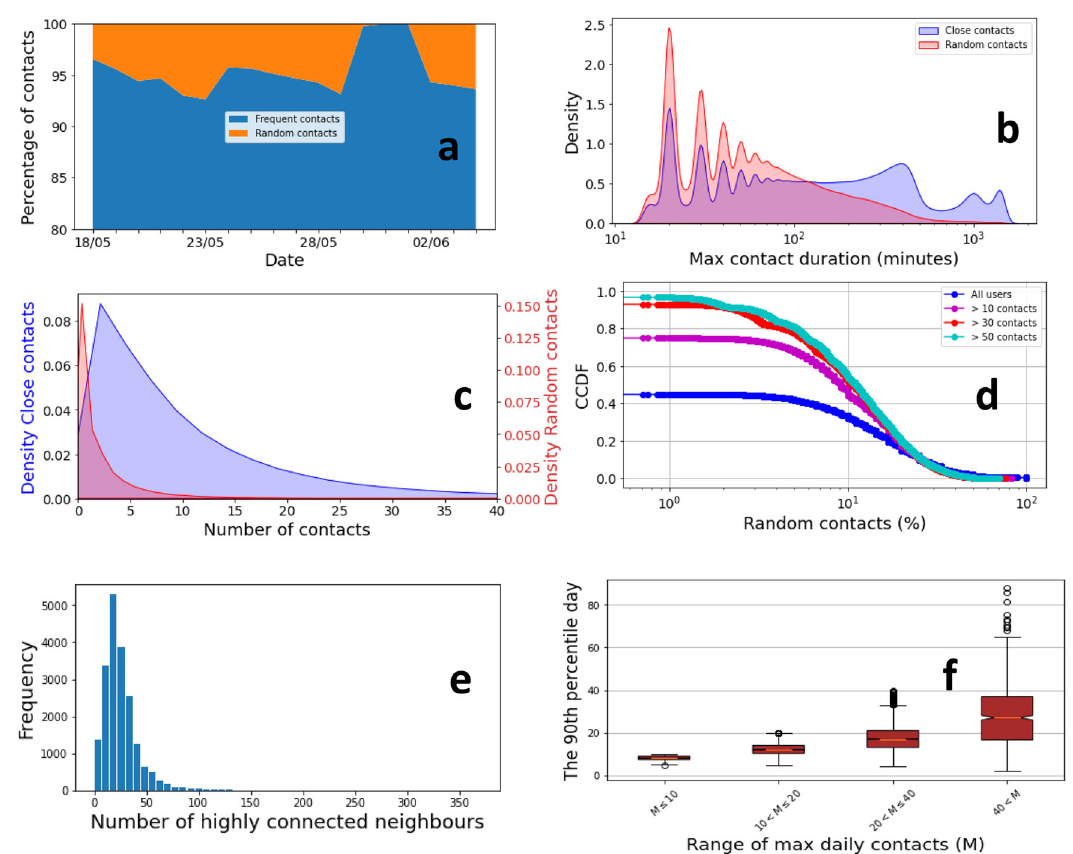
Fig. 3 Quantifying the success in detecting unknown close contacts. a The contacts split over time. The fraction of risky random contacts is stable over time and decreases in weekends and holidays, b The density of encounter duration. Frequent contacts tend to be markedly longer, c The density of the number of contacts per user, which are split based on the inferred contact type, d The Complementary Cumulative Distribution Function (CCDF) of the percentage of random contacts per user for all users, users with 10 contacts or more (49% of all users), users with 30 contacts or more (12% of all users) and users with 50 contacts or more (4% of all users), e The histogram of the number of highly connected neighbours per a highly connected user. A user is highly connected if he/she has 50 or more contacts, f The distribution of the 90 th percentile day in terms of number of daily contacts for highly connected users. Here we grouped highly connected users based on the maximum number of daily contacts per user. In the box-whisker plot, the central line indicates median, box limits indicate upper and lower quartiles, and whiskers specify 1.5 times the interquartile range above the upper quartile and below the lower quartile. The circles above and below the whiskers indicate the samples that are either larger or smaller than the whiskers. These are the outliers in each range. The number of samples N is 794 for M ≤ 10, 9715 for 10 < M ≤ 20, 8035 for 20 < M ≤ 40 and 876 40 ≤ M .